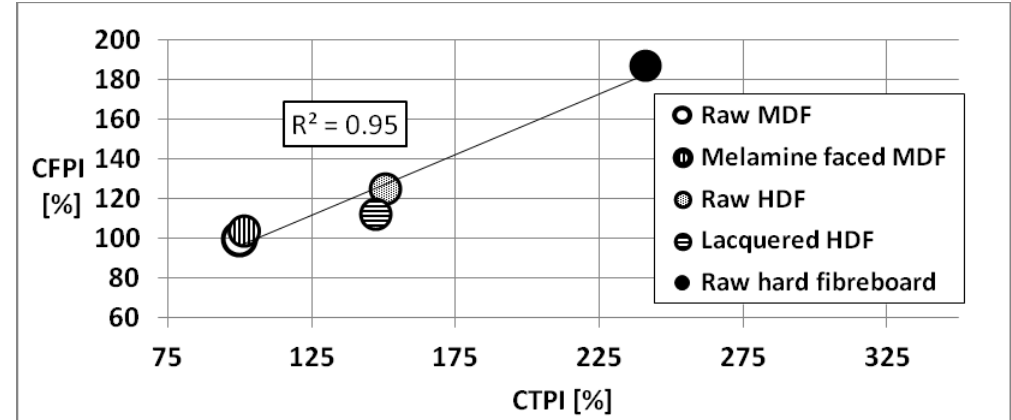
12 Figure 12. The relationship between the significantly reliable (CFPI) and highly simplified (CTPI) machinability indexes which were determined for fiberboards.